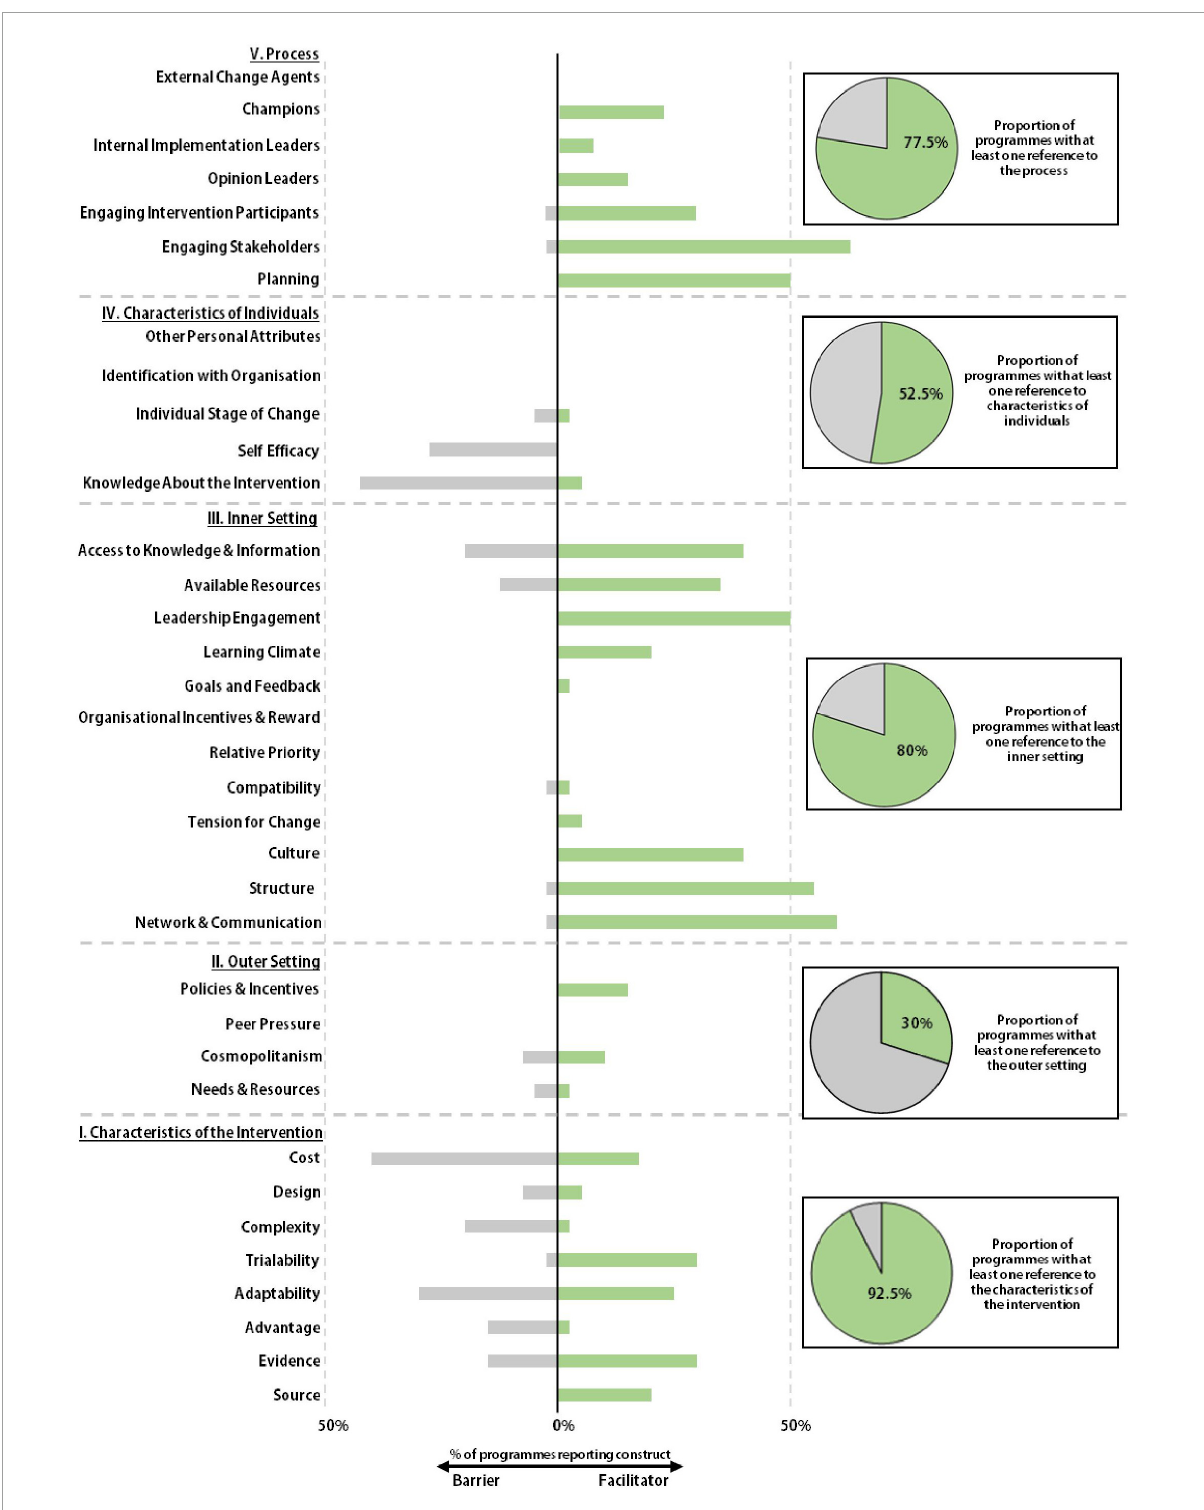
FIGURE4 Facilitators and barriers to implementation. The Consolidated Framework for Implementation Research (CFIR) was used as a framework to identify the barriers and facilitators to implementation at each pharmacogenetic program. Whether a program referenced any construct within a given domain was recorded and displayed as a circle graph. Referenced CFIR constructs were recorded as being described as either a barrier or facilitator to implementation and displayed onto the stacked bar